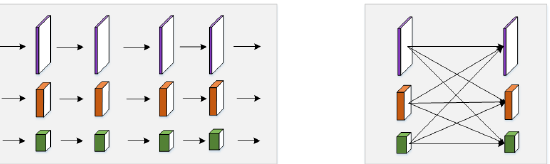
Figure 4. One module in the third stage: the left represents the parallel multi-resolution convolutions and the right displays the multi-resolution